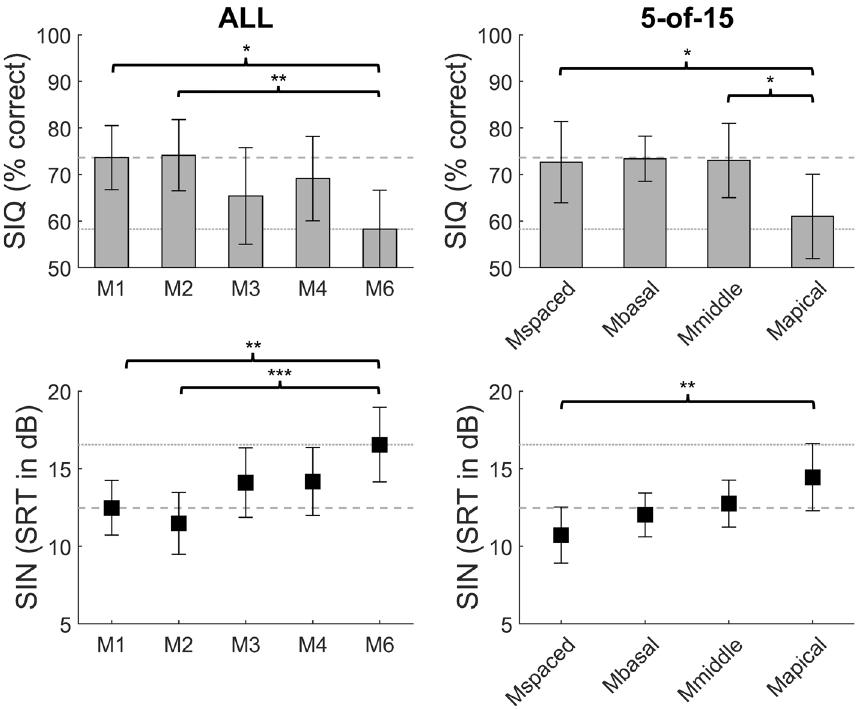
Figure 1. Speech perception results as mean scores for the group of 8 CI recipients when using spectral blurring for all 15 electrode channels (ALL, left) and for 5 out of 15 electrode channels (5-of-15, right). Top: speech perception in quiet (SIQ, in percentage correct), Bottom: speech reception threshold in multi-talker noise (SIN, in dB SNR). Note that for the ALL condition, the map number indicates the blurring factor and in the 5-of-15 condition, all maps used a blurring factor of 6. Error bars indicate standard errors and the dashed and dotted lines were added for visual comparison between the ALL and the 5-of-15 conditions (*: p < 0.05; **: p < 0.01; ***: p <